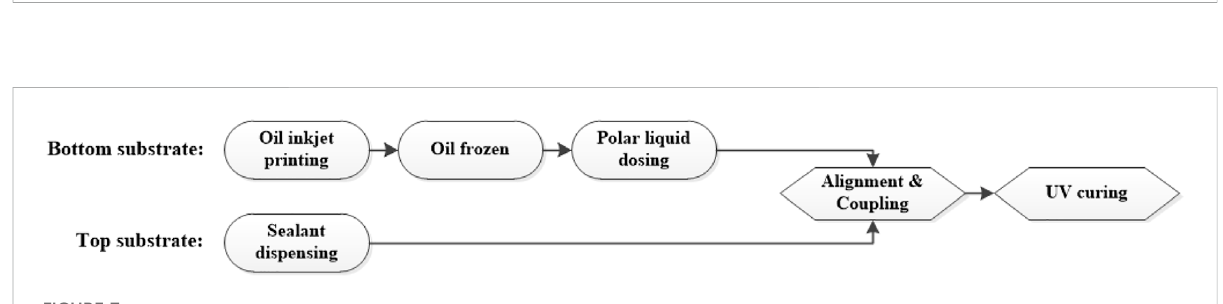
FIGURE 7 Flow chart of phase change fi lling and coupling.